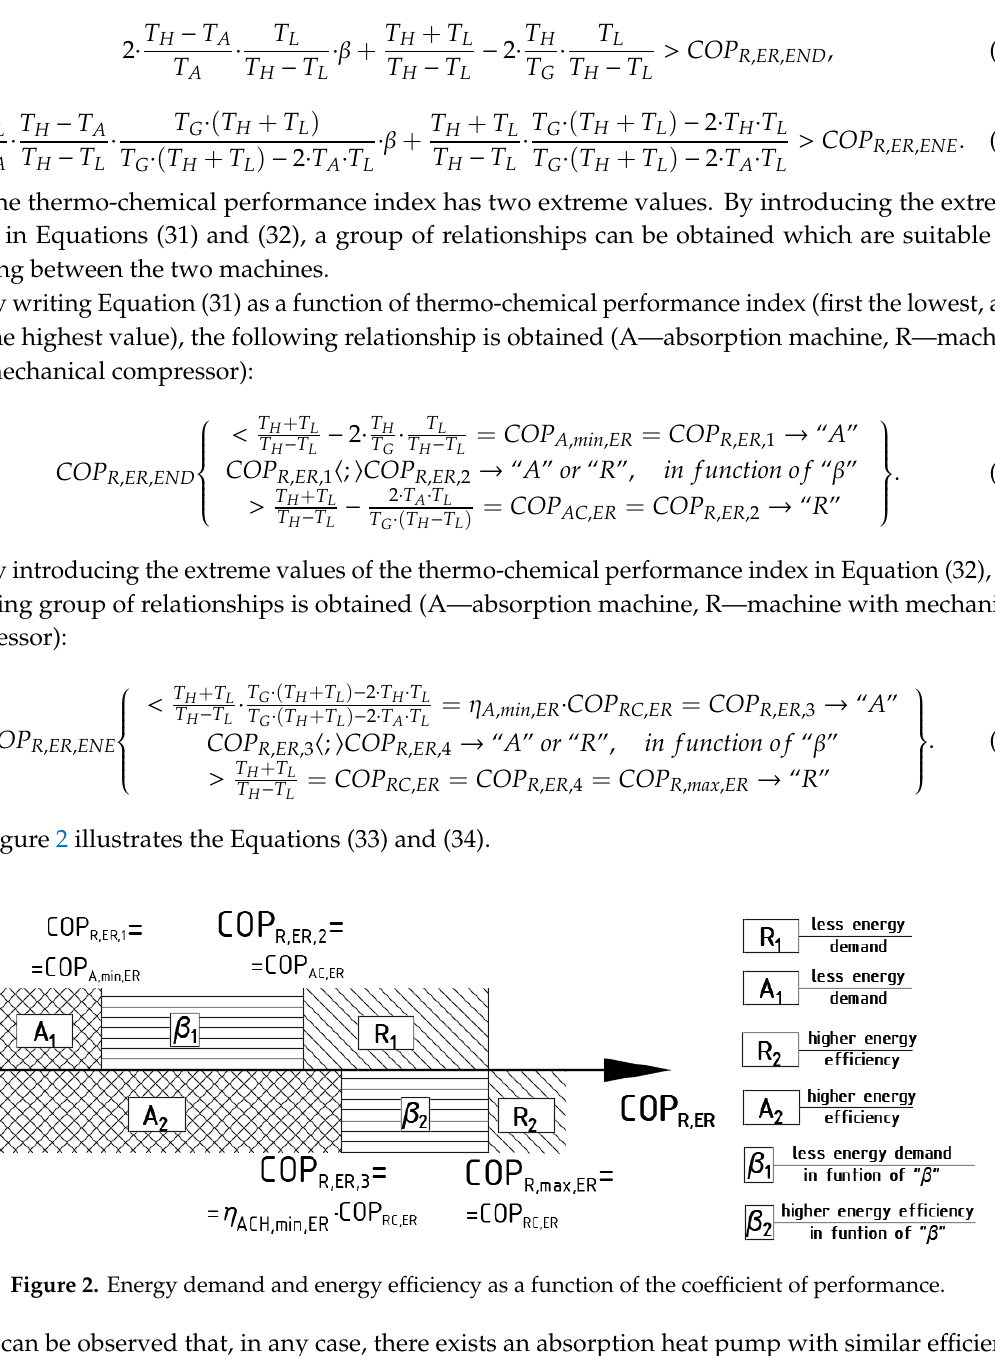
Table 1. Reference data. Denomination